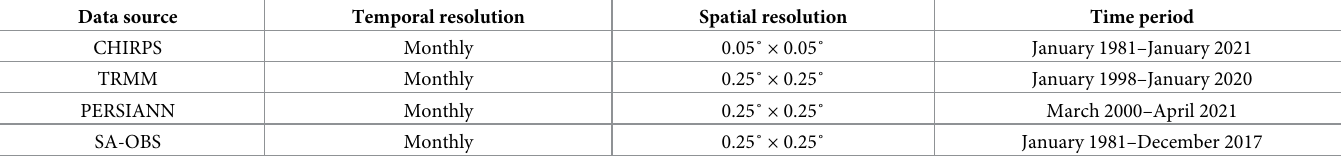
Table 2. Summary of the datasets used in this